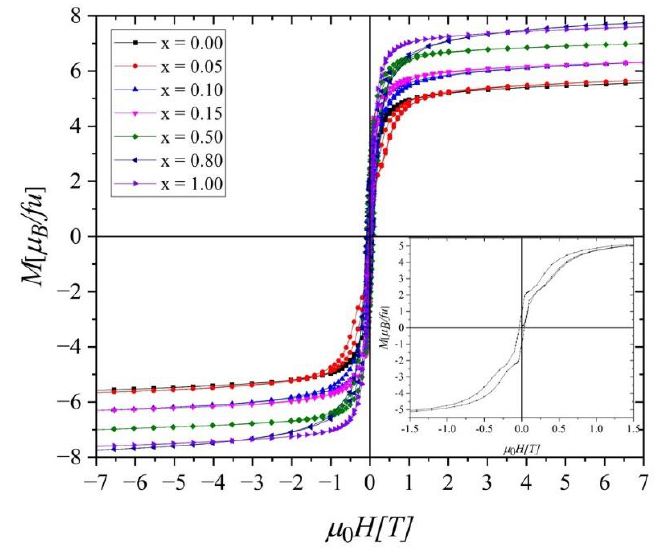
Figure 5. Hysteresis loops measured at 2 K. The inset shows M ( µ 0 H ) in the low magnetic field values range for the sample with x = 0.05. Table 1. Curie temperature ( T C ), saturation magnetization ( M S ) , and 3 d sublattice contribution to the